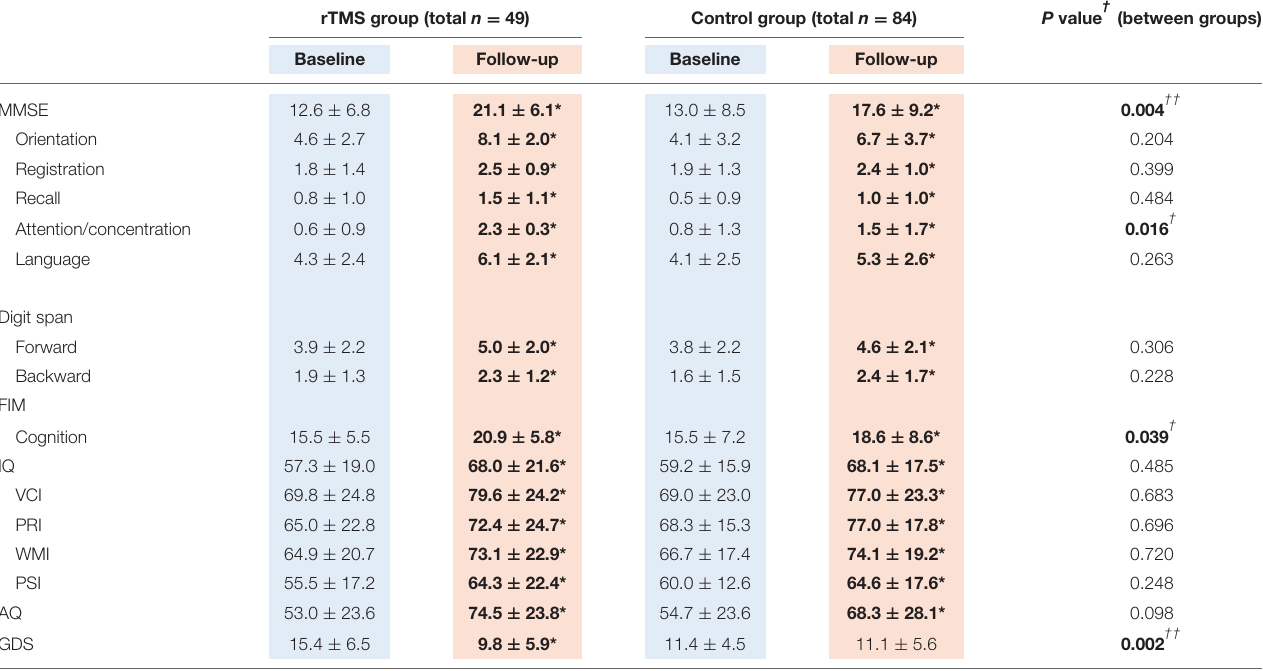
TABLE 3 | Comparison of rehabilitation outcomes between rTMS and control groups (left hemispheric stroke subjects, N =